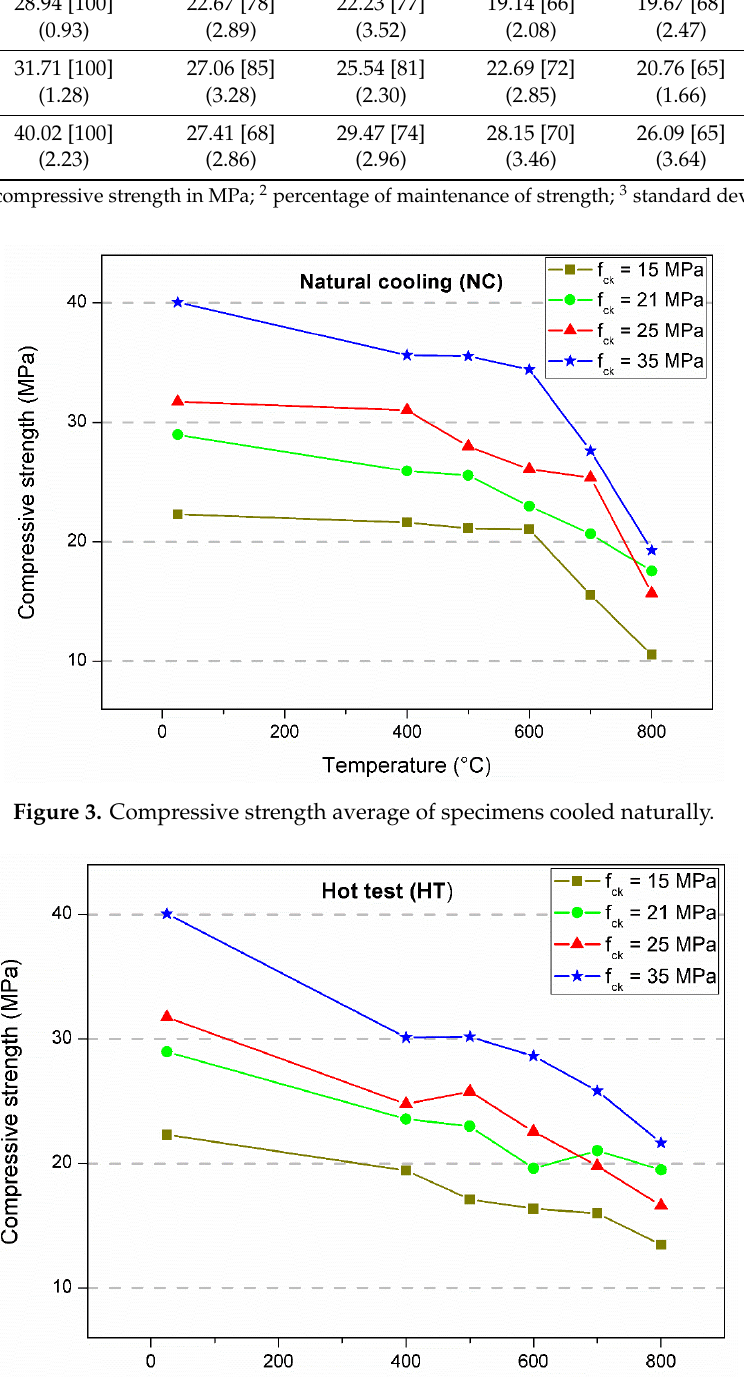
Figure 5. Compressive strength average of specimens cooled after aspersion with water at ambient temperature. 3.2. Statistical Analysis Table 4 shows the ANOVA results. The corrected model and the intercept, the standard models of the analysis program, were significant ( p < 0.05), which enabled the variables to be correlated analytically. The categorical variable test method (M), temperature (T), and theoretical strength (f ck ) were significant ( p < 0.05), which indicates a relevant effect on the compressive strength. The effect size was moderate for the test method and more intense for the temperature and strength variables. However, the values obtained indicate a significant influence of the conditions on the strength. The power observed was the maximum for all situations evaluated. The adopted model can explain 88% of the observed values (coefficient of determination R square = 0.880). Therefore, the obtained data are statistically significant and adequately explain the proposed problem.